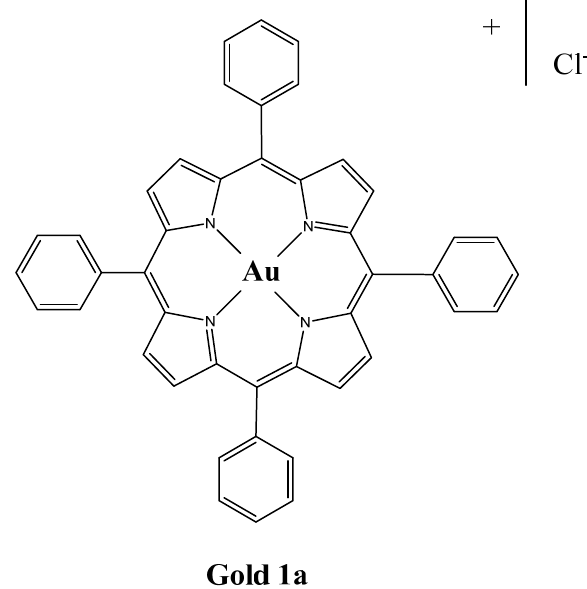
Figure 17. Chemical structure of compound Gold 1a [111].